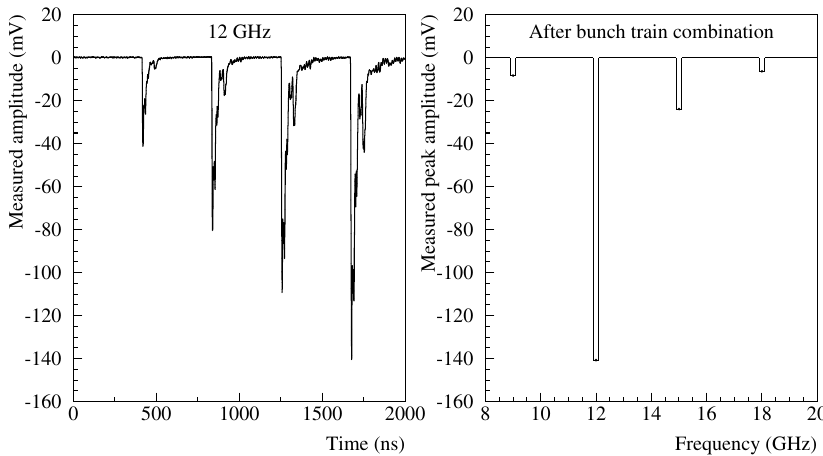
FIG. 29. Bunch frequency monitor signals at 12 GHz, while a bunch train combination with a factor 4 occurs (left panel) and amplitude of the four harmonics of interest measured on the oscilloscope at the end of the bunch frequency multiplication (right panel).